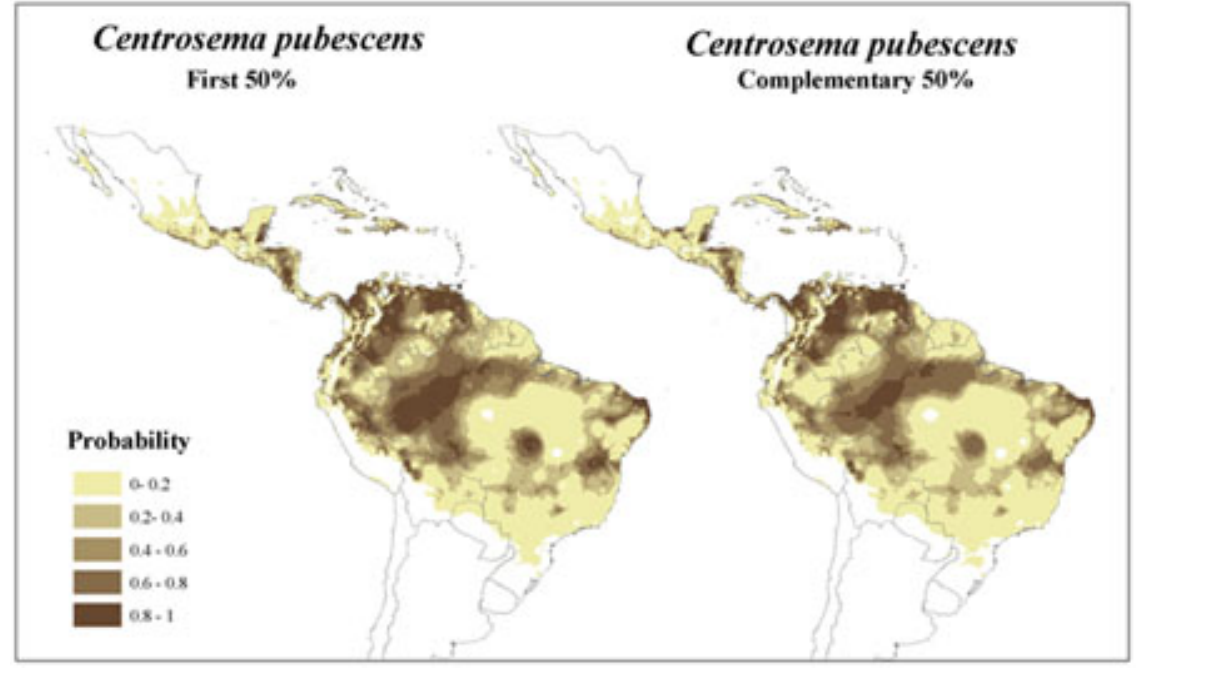
Fig. 1 . Probability distribution of Centrocema pubescens with the sample divided into two random equal